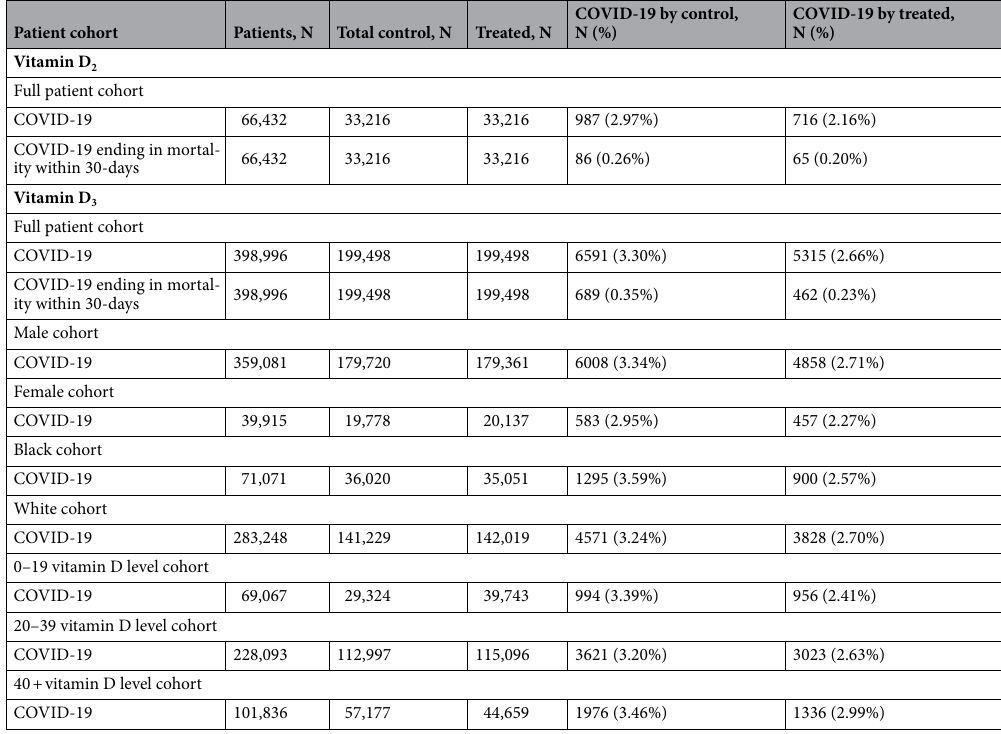
Table 3 and Fig. 1. The resulting vitamin D associations were identical to two decimals places after adjusting for seasonality. The null hypothesis of a proportional hazards model for COVID-19 infection on Vitamin D supplementation was rejected (vitamin D 2 : Chi-Square = 13.98, df = 1, P < 0.001; vitamin D 3 : Chi-Square = 110.95, df = 1, P < 0.001).